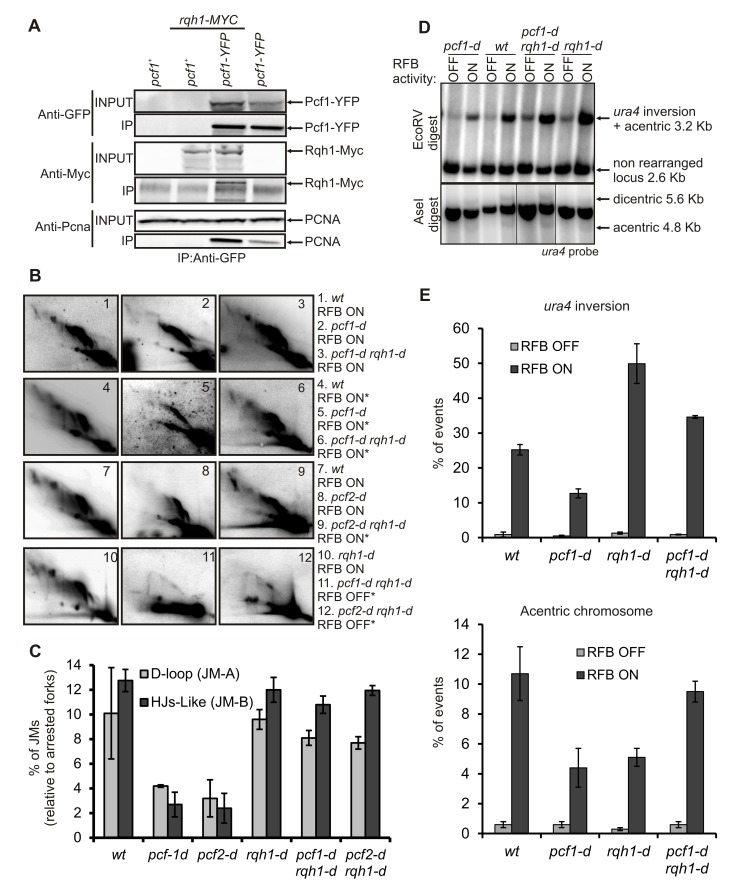
CAF-1 counteracts D-loop dismantling by the RecQ helicase Rqh1.(A) CAF-1 and Rqh1 physically interact. Immunoprecipitation of Pcf1-YFP by anti-GFP antibody in indicated strains. After protein separation by electrophoresis, samples were analyzed using anti-GFP antibody to reveal Pcf1-YFP, using anti-Myc to reveal Rqh1-MYC, and anti-PCNA. (B) Analysis of RIs by 2DGE in indicated strains and conditions; ON and OFF refers to the RTS1-RFB being active or not, respectively. Stars indicate DNA samples that have been cross-linked prior to extraction. Panels 1 to 3, 8, and 10 were done in the same set of experiments and panels 4 to 6 and 9 in another set of experiments. (C) Quantification of panel B. Values are the means of three independent experiments ±SD. Refer to Data S1, sheet 5. (D) Analysis of chromosomal rearrangements by Southern blotting using ura4 probe (see Figure S2 for details). Indicated strains were grown with (RFB OFF) or without thiamine (RFB ON) for 48 h. Restriction enzymes and the origin of each signal are indicated. (E) Quantification of panel D in indicated strains. Values are the means of at least three independent experiments ±SD. Refer to Data S1, sheet 6.